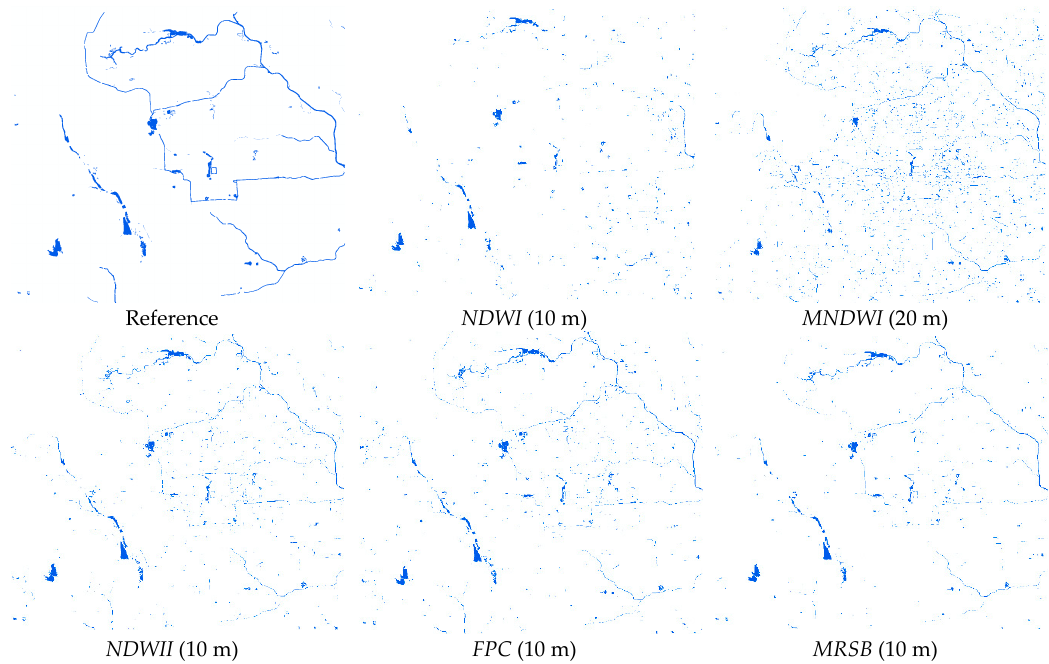
Figure 9. Final surface water maps (blue blocks) utilizing different approaches in Beijing. The reference image is the manual drawing by visual interpretation process.